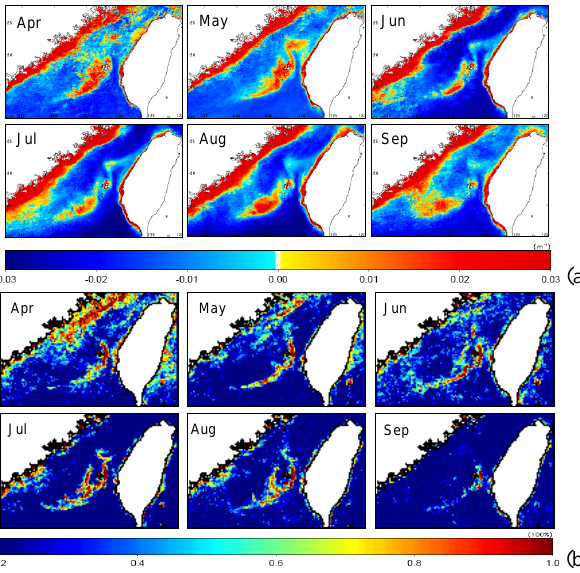
Fig. 6. (a) Spatial anomaly of Aph in the TWS in April–September; (b) thermal frontal probability in April–September. valid pixels to retrieve the ABI (the grey bar), the along- shore wind stress anomaly (the solid circle), and the Multi- variate ENSO Index (MEI, http://www.cdc.noaa.gov/people/ klaus.wolter/MEI/; the red and blue curve indicates occur- rence of El Ni ˜ no and La Ni ˜ na, respectively). The ABI peaks in 2008 and is the lowest in 2004, and is well corre- lated with the alongshore wind stress anomaly ( R 2 = 0 . 67, n = 7). More positive alongshore wind stress anomalies cor- hanced upwelling, offshore advection of river plumes,